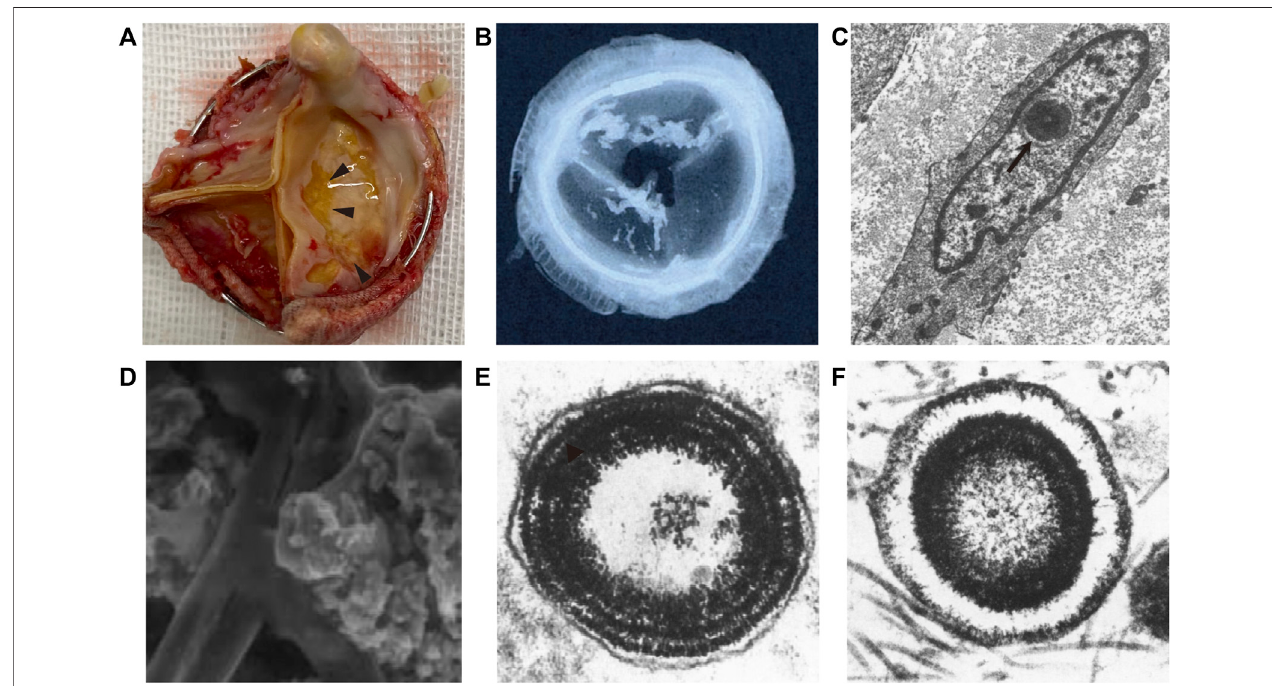
FIGURE1| Schematicofbioprostheticheartvalvecalci fi cation. (A) Grossviewofbioprostheticheartvalvecalci fi cation(arrowhead). (B) Low-energyradiographyof bioprosthetic heart valve calci fi cation (Delogne et al., 2007). (C) Ultrastructure of calcium deposits in the cell nuclei (arrow) (Schoen et al., 1994). (D) Scanned electron microscopyviewofcalci fi clocidepositingoncollagenandelastin(Delogneetal.,2007). (E,F) calcospherulaearrangedinconcentricringswithandwithoutacentralcore (Valente et al., 1985).